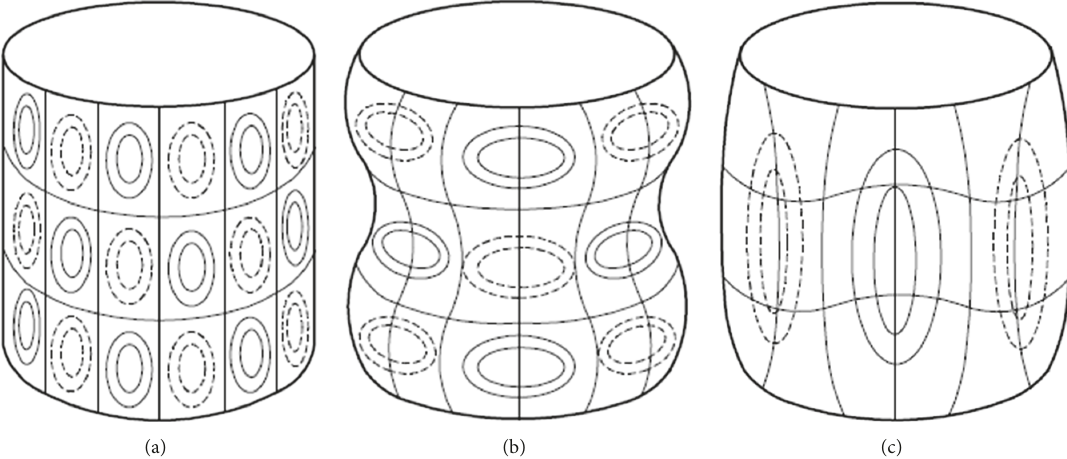
Figure 2: Three different limit state schematic representations: (a) local shell buckling, (b) bay buckling, and (c) general buckling [32].